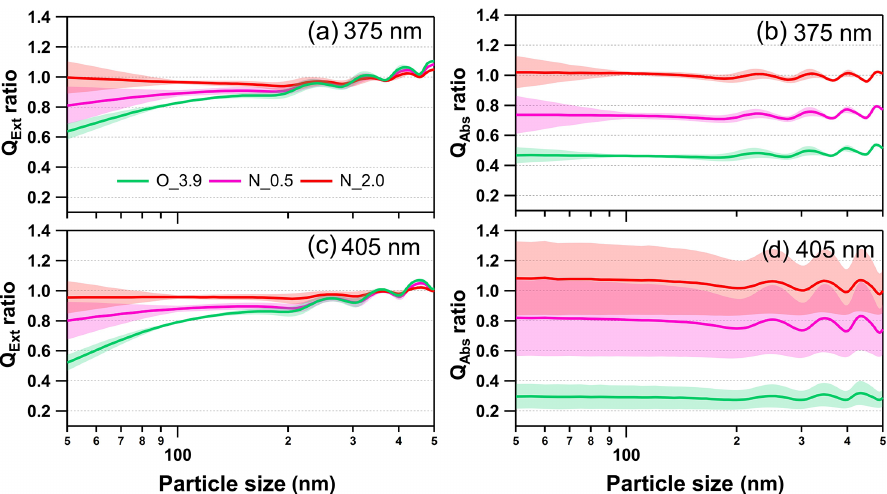
Figure 10. Size-resolved light extinction and absorption efficiency ratio of NO x -dependent photooxidized tar balls compared to the fresh tar ball particles: (a) and (c) extinction ratios at 375 and 405nm; (b) and (d) absorption ratios at 375 and 405nm. O_3.9 represents 3.9 days’ equivalent atmospheric photochemical aging in the absence of NO x ; N_0.5 and N_2.0 indicate photochemical oxidation with 0.5%vol and 2.0%vol N 2 O addition at ∼ 4 . 0 days’ atmospheric oxidation.